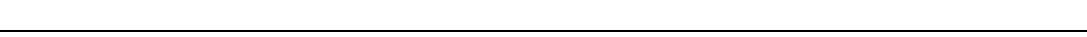
Fig. 1 High-throughput sequencing reveals recessive mutations of MAGI2 , TNS2, DLC1, CDK20, ITSN1, or ITSN2 as causing NS in humans. a Renal histology of individual A5146-21 with focal segmental glomerulosclerosis (FSGS) and MAGI2 mutation (scale bar = 50 μ m). b Exon structure of human MAGI2 cDNA and mutations. Below is the protein domain structure of MAGI2, showing GuK, WW1, WW2, and six different PDZ domains. Two different homozygous truncating mutations of MAGI2 were detected in two families with NS and neurological impairment. c Homozygosity mapping identi fi es ten recessive candidate loci (red circles) in family A1358 with NS, and WES identi fi es a homozygous mutation of TNS2 (p.Arg292Gln). Non-parametric lod scores (NPL) were calculated and plotted across the human genome. The TNS2 locus (arrowhead) is positioned within one of the maximum NPL peaks on chromosome 12q. d Exon and protein domain structure of human TNS2. Six different TNS2 mutations were detected in fi ve families with NS. Family numbers and amino acid changes are given (Supplementary Table 1). Arrow heads denote altered nucleotides. Lines and arrows indicate positions of mutations in relation to exons and protein domains. Family numbers with compound heterozygous mutations (het) are highlighted in gray. e Renal histology of individual A4967-21 with FSGS and DLC1 mutations. TEM reveals podocyte foot process effacement (arrow heads, magni fi cation 8000x). f Exon and protein domain structure of human DLC1. The SAM, RhoGAP, and START domains are depicted by colored bars, in relation to encoding exon position. Six different DLC1 mutations were detected in four families with NS. Positions of amino acid changes (Supplementary Table 1) are marked with arrowheads. g Renal histology of individual A5013-21 with membranoproliferative glomerulonephritis (MPGN) and mutation in CDK20 . TEM reveals podocyte foot process effacement and thickening of glomerular basement membrane (arrow heads, magni fi cation 7000x). h Homozygosity mapping identi fi es twelve recessive candidate loci (red circles) in family A5013 with NS, and WES identi fi es a homozygous mutation of CDK20 (p.Phe204Leu), positioned within one of the maximum NPL peaks on chromosome 9q. i Exon and protein domain structure of human CDK20. The serine threonine kinase (S_TKc) domain is depicted by a colored bar, in relation to encoding exon position. One homozygous mutation in CDK20 was detected in family A5013 with NS. j Homozygosity mapping in family A3706 with NS identi fi es 17 recessive candidate loci (red circles), and WES identi fi es a homozygous mutation of ITSN1 (p.Pro180Ser), positioned within one of the maximum NPL peaks on chromosome 21q. k Exon and protein domain structure of human ITSN1. Five different ITSN1 mutations were detected in three families with NS. l Renal histology of Patient-1 with mutations in ITSN2 revealed minimal change disease (scale bar = 50 μ m). EM showed foot process effacement (scale bar = 2 μ m). m Exon and protein domain structure of human ITSN2. Three different ITSN2 mutations were detected in two families with